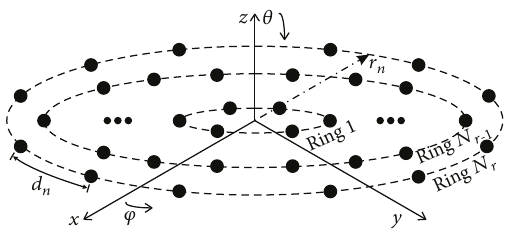
Figure 1: Typical geometry of a concentric circular ring